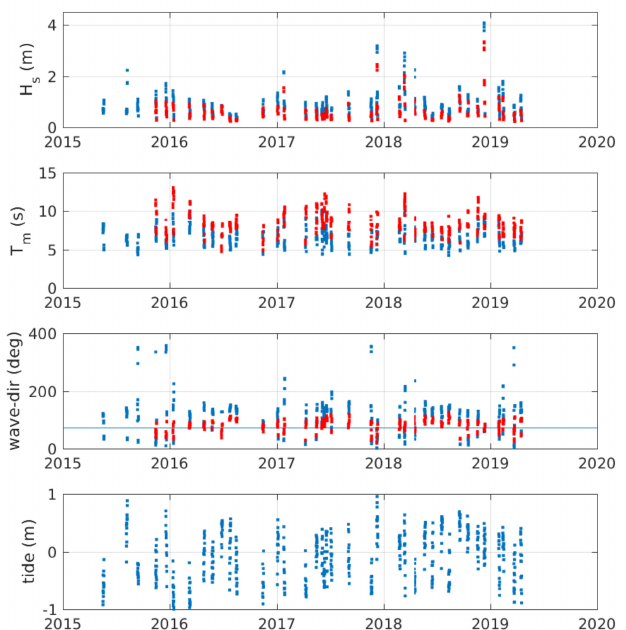
Figure 7. Time series of wave height, H s , wave period, T m , peak wave direction, and tide elevation for each of the 624 cBathy estimates collected over almost four years. Blue dots for the upper three panels correspond to estimates from the 26 m depth waverider buoy. These are overplotted with red dots from the 8 m array. Shore normal wave direction is 72 ◦ , indicated by the blue horizontal line in the wave direction